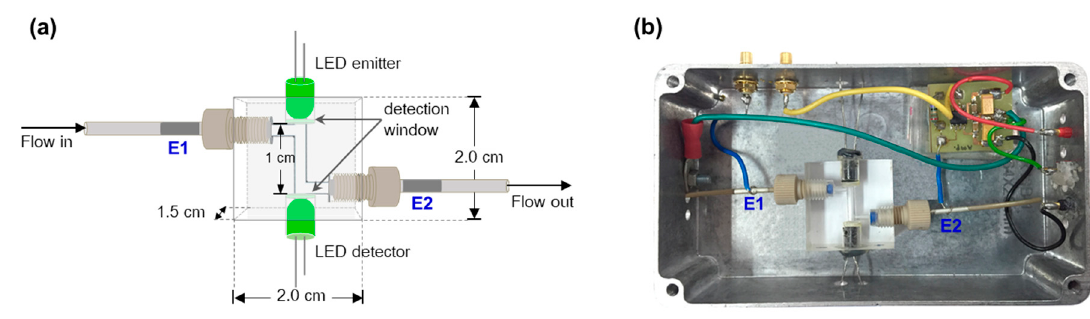
Figure 1. ( a ) Schematics of C4D-PEDD flow-through detection cell for the “2-in-1” detector for simultaneous detection. ( b ) Photograph of the “2-in-1” C4D-PEDD flow-through detection cell and the pre-amplifier board.